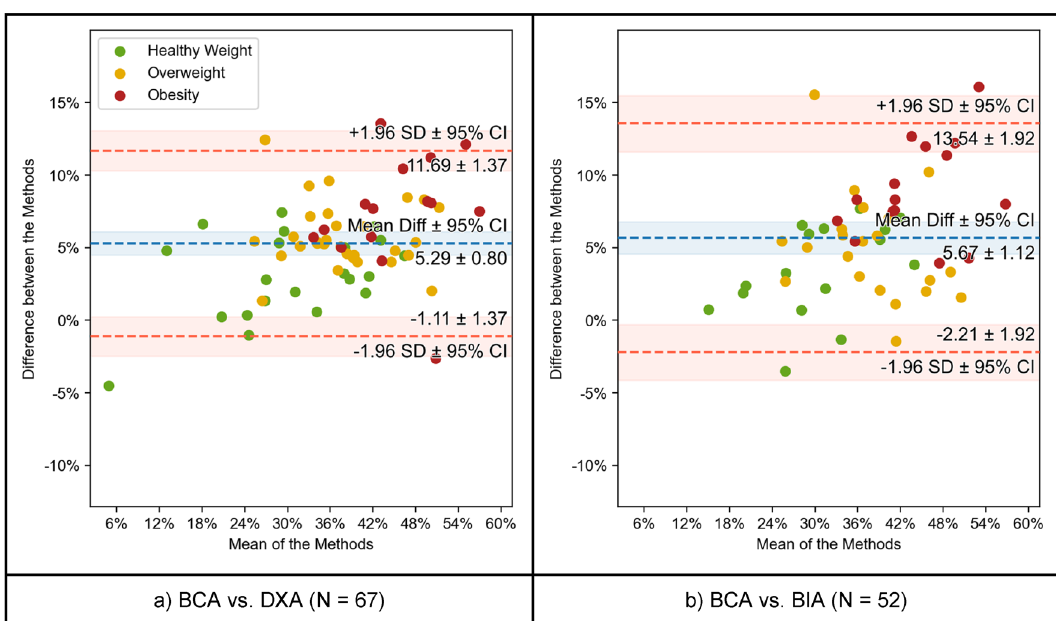
Figure 4. Comparison of BFR between BCA vs. DXA (left) and BCA vs. BIA (right) using Bland–Altman (or mean-difference) plots. Each data point has been colored according to the BMI category of the patient it represents. The mean difference and the limits of agreement are shown in blue and red, respectively, together with their 95% confidence